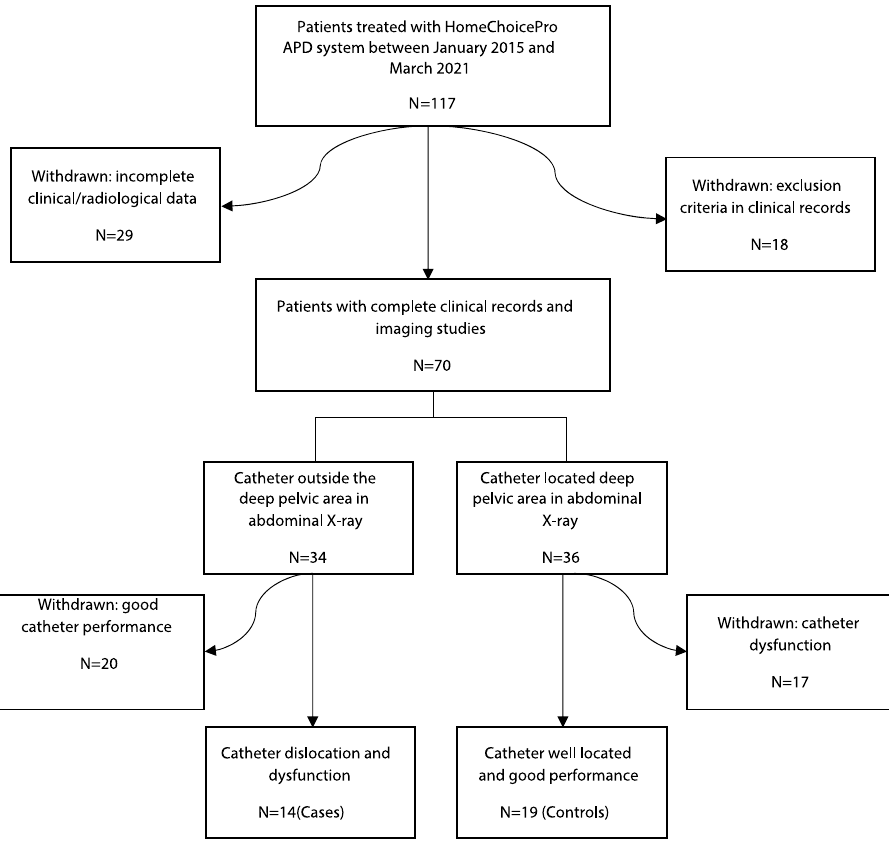
Figure 2. Flow chart of cases and controls